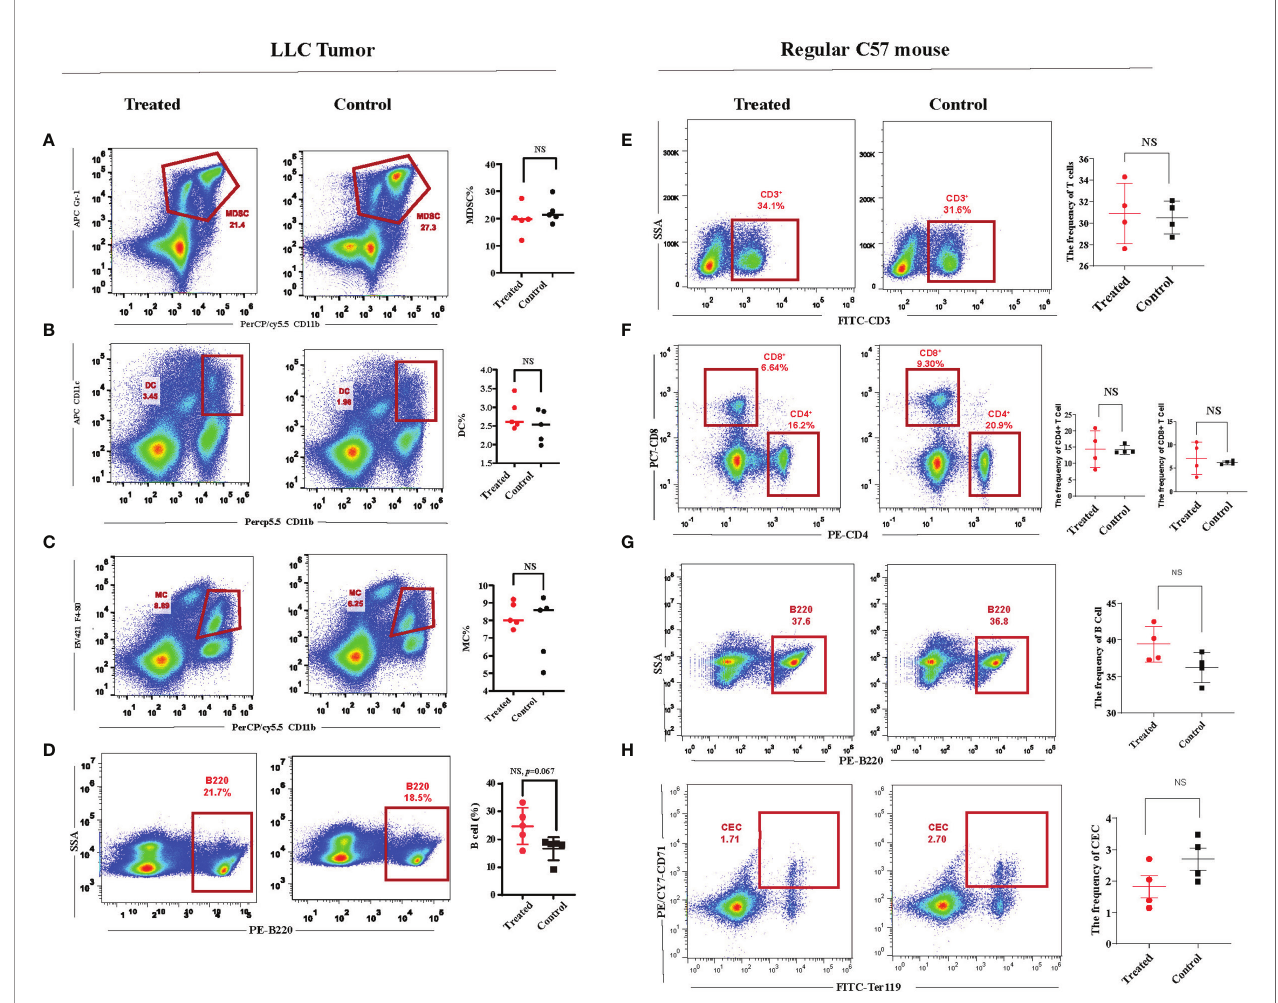
FIGURE 3 | Immunity of the regular C57 mice could not be affected by ultrasound-targeted microbubble destruction (UTMD). (A – D) Representative fl ow cytometry dot plots and cumulative composite data of the frequency of dendritic cells, microphages, myeloid-derived suppressor cells (MDSCs), and B cells in the spleen of the tumor-bearing mice. Each point represents data from an individual mouse (n = 5). (E – H) Representative fl ow cytometry dot plots and cumulative composite data of the frequency of T cells, CD8 + T cells and CD4 + T cells, CD71 + erythroid progenitor cells (CECs), and B cells in the spleen of the regular C57 mice. Each point represents data from an individual mouse (n = 4). NS, no signi fi